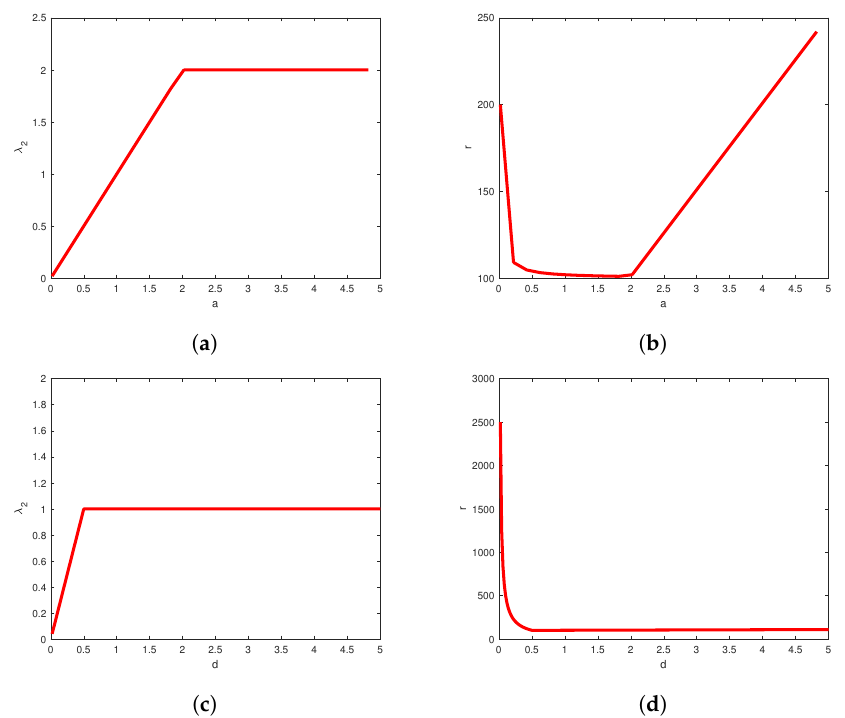
Figure 6. The synchronizability of Networks-B. Panel ( a ) depicts λ 2 vs. a and ( b ) depicts r vs. a when M = 2, η = 100, d = 1; Panel ( c ) depicts λ 2 vs. d and ( d ) depicts r vs. d when M = 2, η = 100, a =